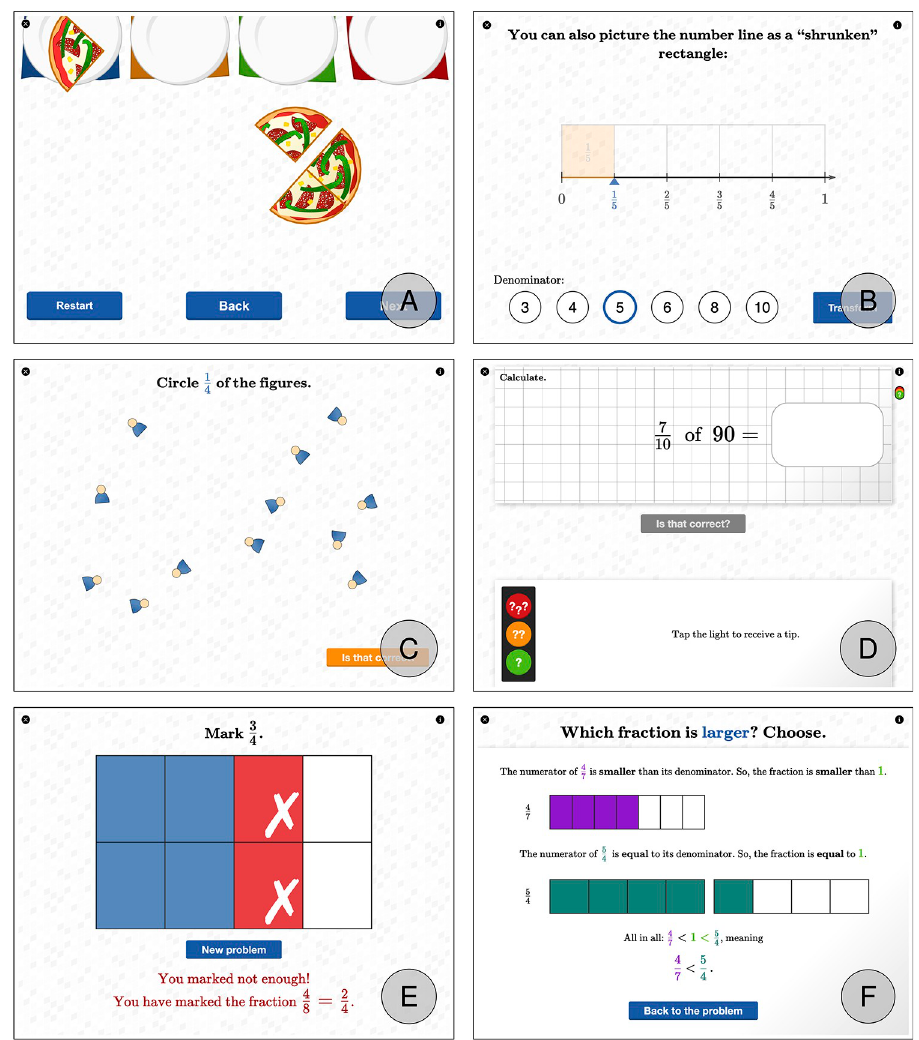
Fig 1. Technological implementation of digital support principles within the e-textbook. (A) Exploratory task involving congruent gestures, i.e., cutting through pizza in terms of swiping over a touchscreen. (B) Interactive diagram showing the conceptual idea of the number line as a shrunken tape diagram—here displayed using overlay technique. (C) Task with adaptive adjustment of task difficulties that represent difficulty generating factors, i.e., number of items equals denominator in level 1, number of items is twice or thrice the denominator in level 2. (D) Task offering graded assistance during problem-solving which students can access by tapping on the traffic lights. (E) Feedback for an incorrect answer based on students’ wrong answers. (F) Feedback for an incorrect answer based on an algorithm choosing an appropriate strategy for the comparison of two